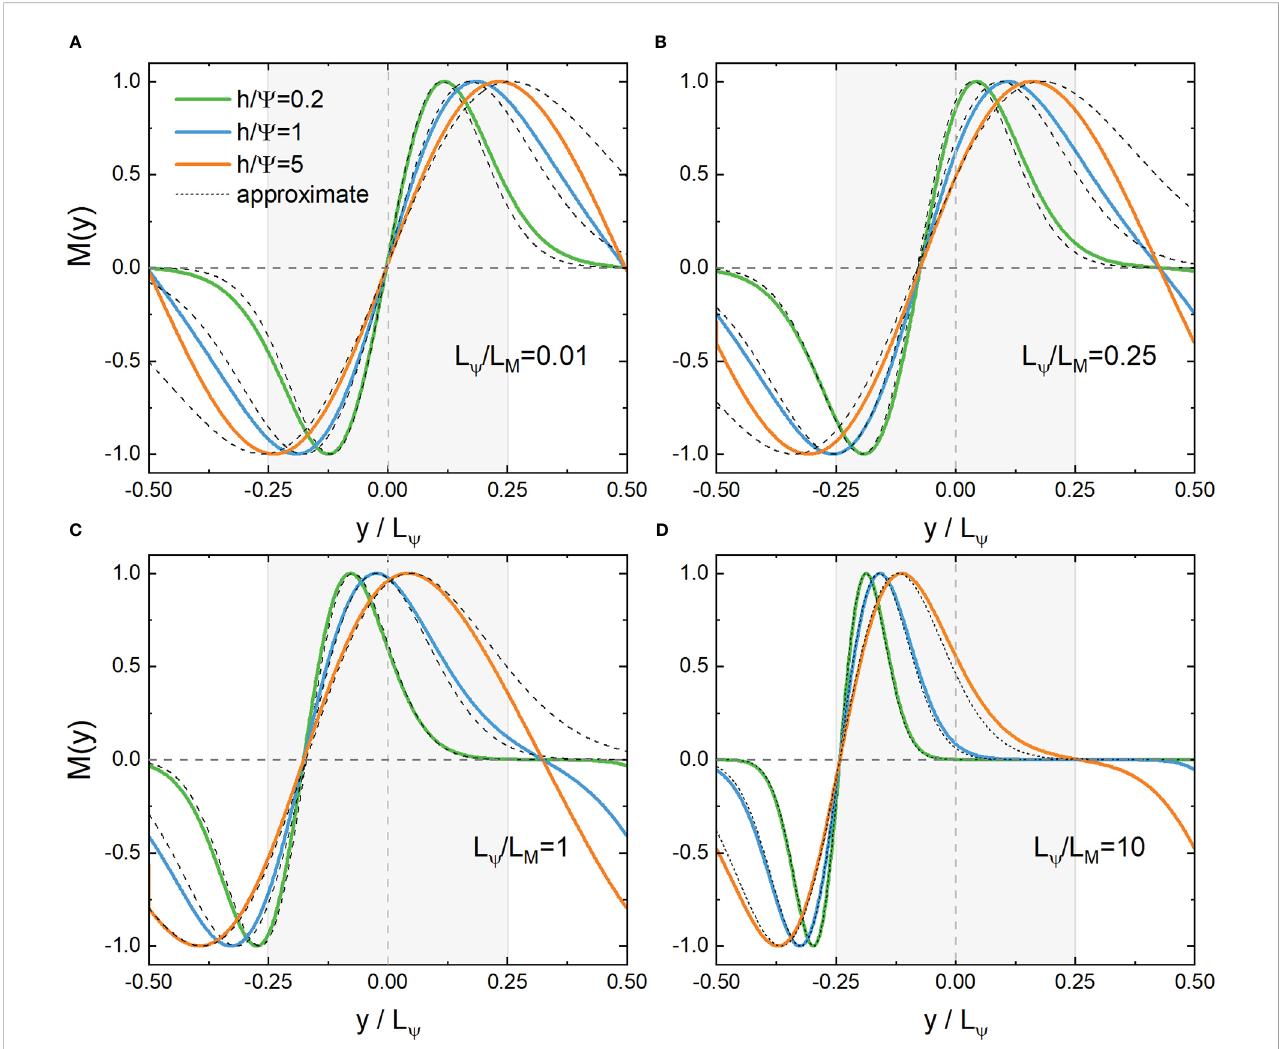
FIGURE 2 Distribution of the odd eigenfunction M S ( w ′ , x , y ′ ) and its approximate solution near the core ( y =0) (A, B) or boundary ( y / L Y = − 1/4) (C, D) with the lowest eigenvalues. L y / L M = k x / k 0 =0.01,0.25,1,10 , h = Y =